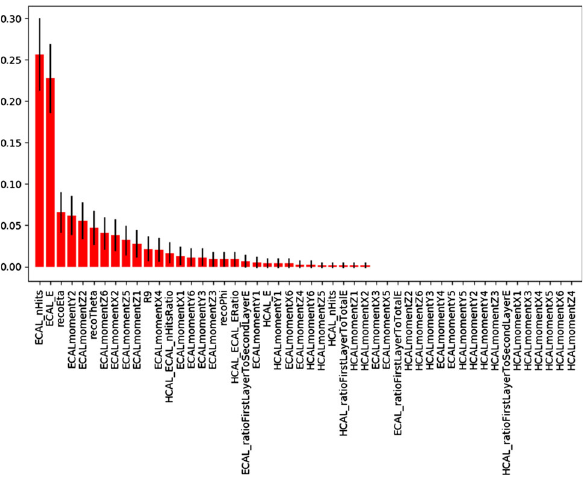
Fig. 25 Feature importances for inputs used in BDT training. Values shown are gini importances [47]